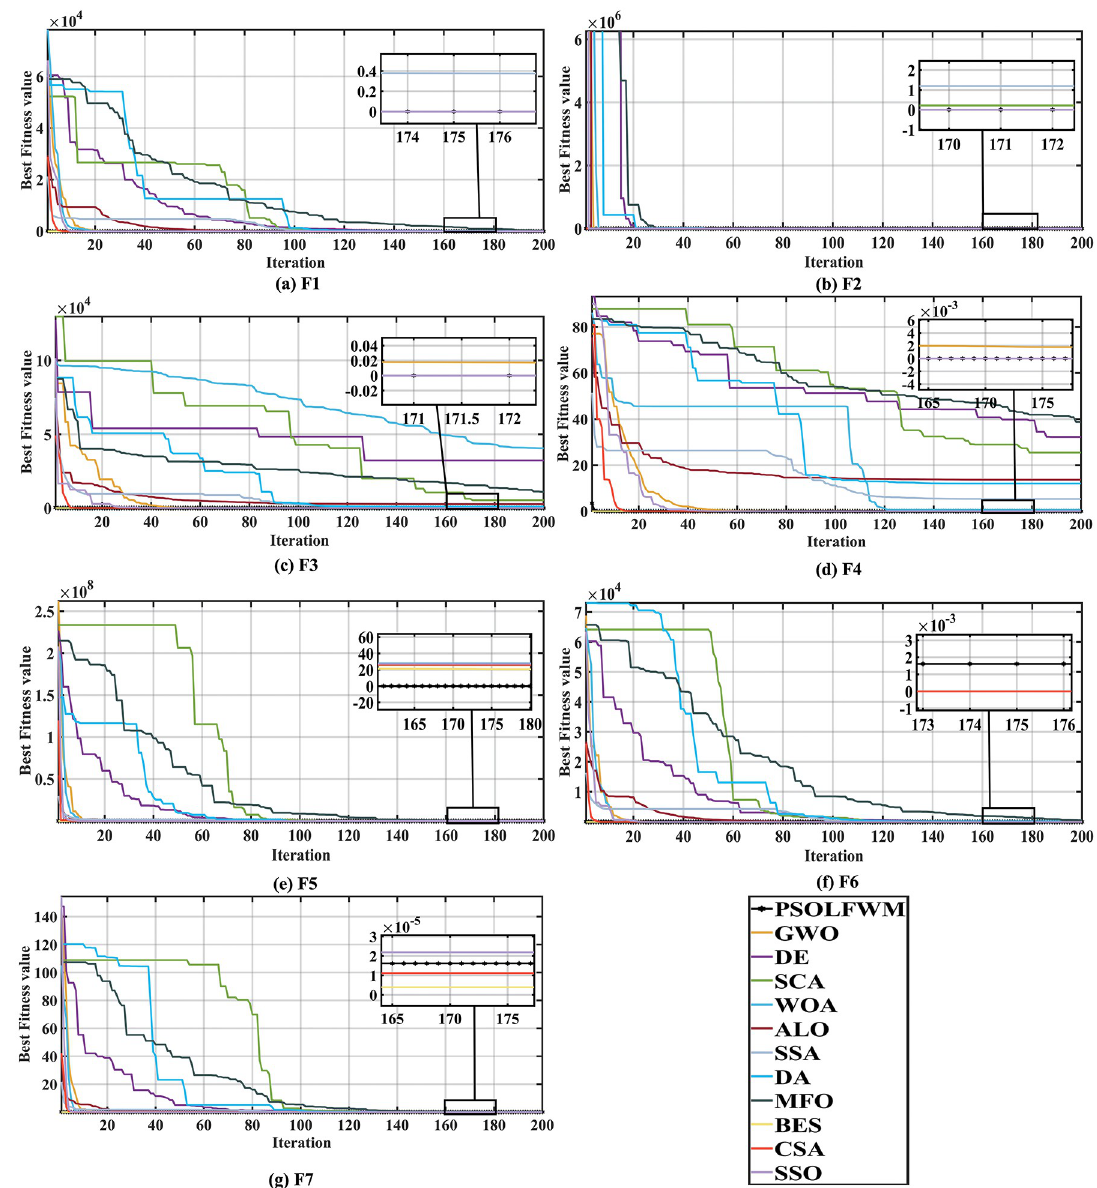
Fig 4. Convergence curve of unimodal functions compared with the meta-heuristic algorithms. (a) F1, (b) F2, (c) F3, (d) F4, (e) F5, (f) F6, and (g) F7.